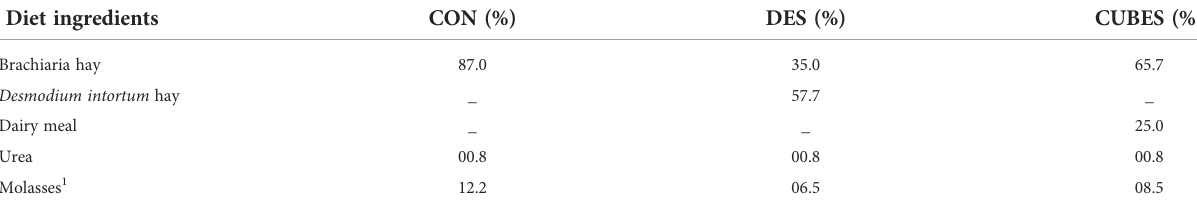
TABLE 2 Proportion (in % DM) of the different feed ingredients used in the formulation of the three experimental diets: control diet consisting mainly of Urochloa brizantha var. Xaraes hay (CON); control diet plus Desmodium intortum hay (DES) and control diet plus commercial dairy supplement (dairy cubes, CUBES).